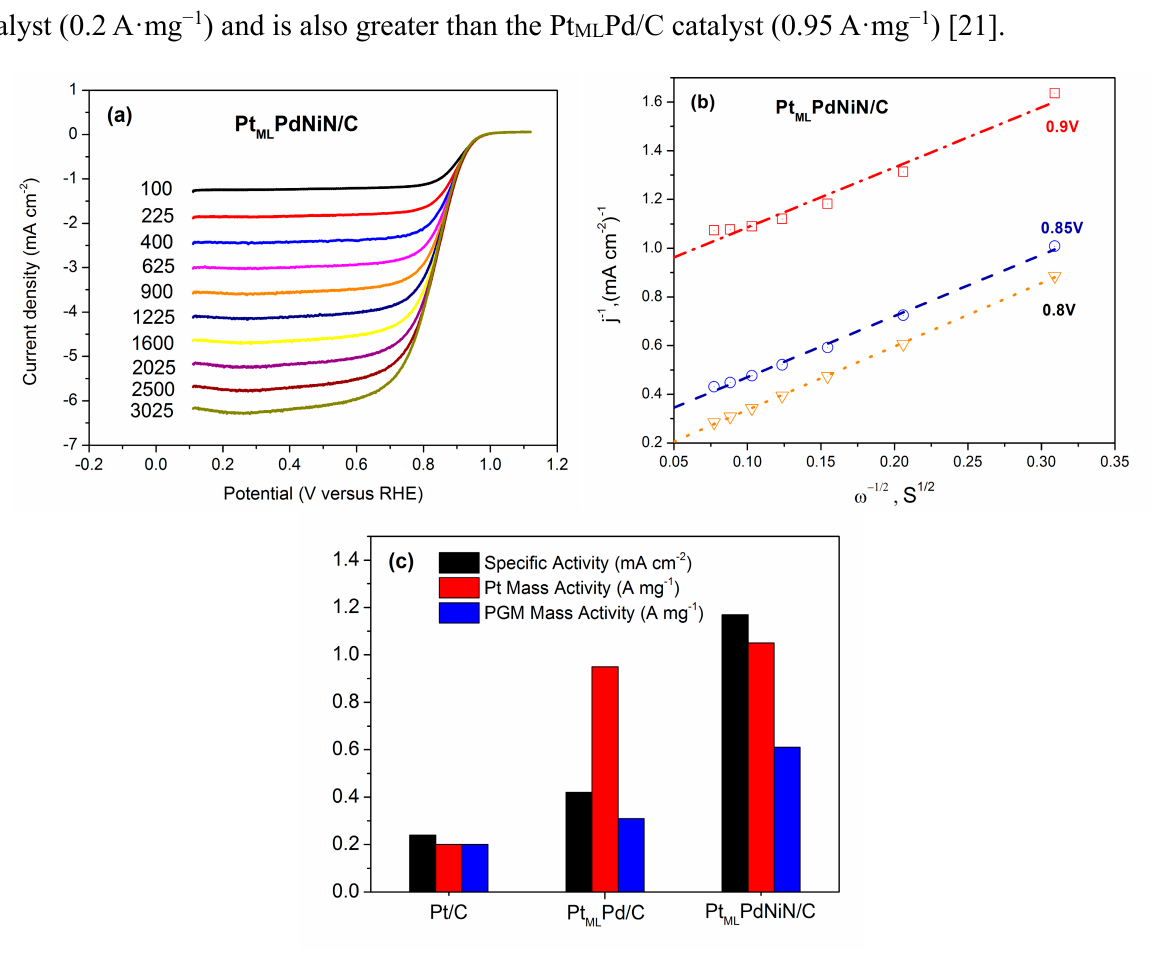
Figure 4. ORR polarization curves for the Pt ML PdNiN/C nanoparticles in 0.1 M HClO 4 solution at a scan rate of 10 mV·s − 1 at various rpm. ( b ) The Koutechy-Levich plots at 0.8 V, 0.85 V and 0.9 V obtained from the ORR polarization curves as shown in ( a ). ( c )